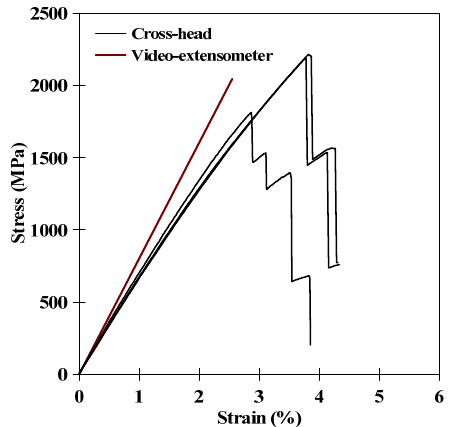
Figure 15. Comparison between the stress–strain curves of the basalt textile obtained from the video-extensometer (average curve) and the machine crosshead.